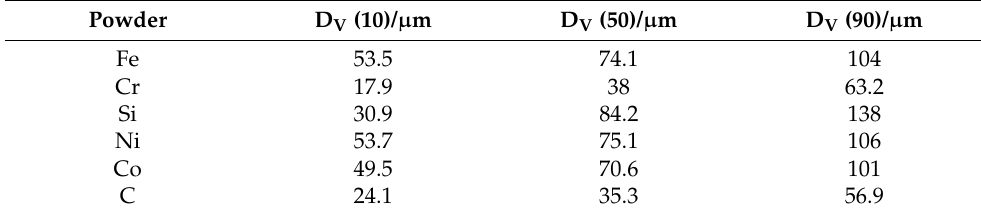
Figure 1. FeCrSiNiCoC mixed powder: ( a ) SEM morphology and EDS; ( b ) particle size distribution. Table 2. Particle size distribution of different